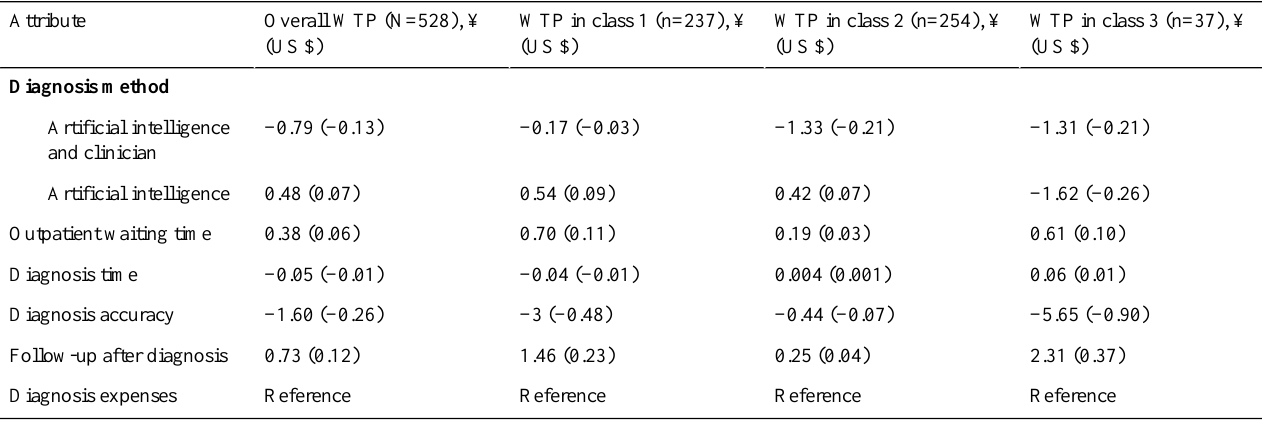
Table 4. Respondents’WTP a in 2020.